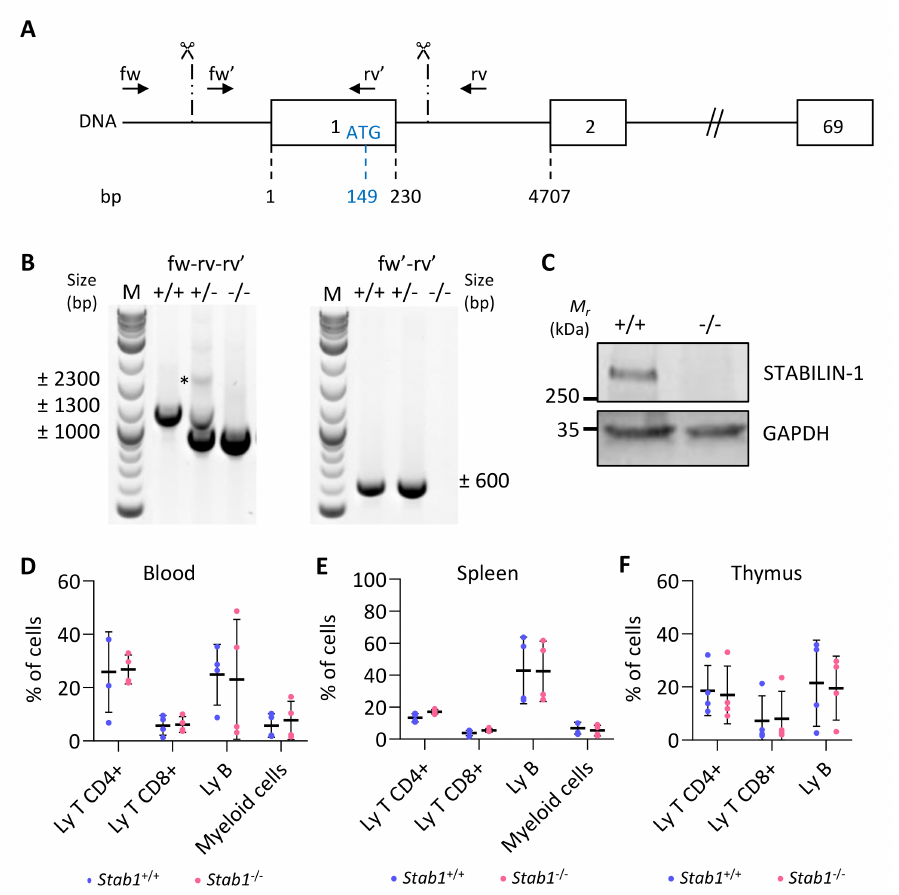
Figure 3. CRISPR/Cas9-based editing of Stabilin-1 gene does not affect immune status of unchal- lenged mice. ( A ) Schematic representation of the Stab1 locus with exons represented as boxes (only exons 1, 2, and 69 out of the 69 are illustrated). Numbers below indicate the position of the exon limits with respect to the transcription initiation site (+1). The position of the ATG (149 bases downstream of the +1) in the first exon is also indicated. Scissors and vertical dashed lines indicate the approximate region where the cuts occurred. Localization of genotyping primers is represented by black arrows. ( B ) Illustrative genotyping results for wildtype (+/+), heterozygous (+/ − ), and knockout ( − / − ) mice, ( C ) Western blotting of STABILIN-1 protein in lymph node lysate from wildtype (+/+) and